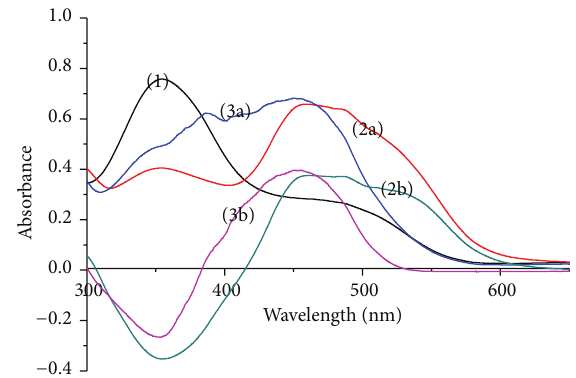
Figure 1: Absorption spectra of TEAC (1), TEAC-Pb(II) (2a), and TEAC-Cr(III) (3a) against methanol-water solvent, TEAC-Pb(II) (2b), and TEAC-Cr(III) (3b) complex against reagent blank.